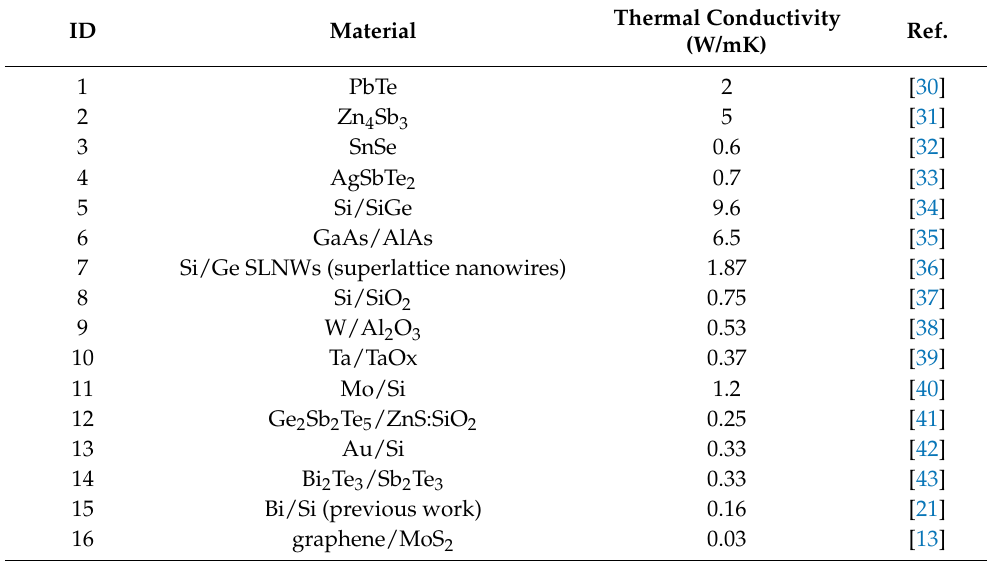
Table 4. Thermal conductivity at room temperature (R.T.) of the reported inorganic pore-free materials.